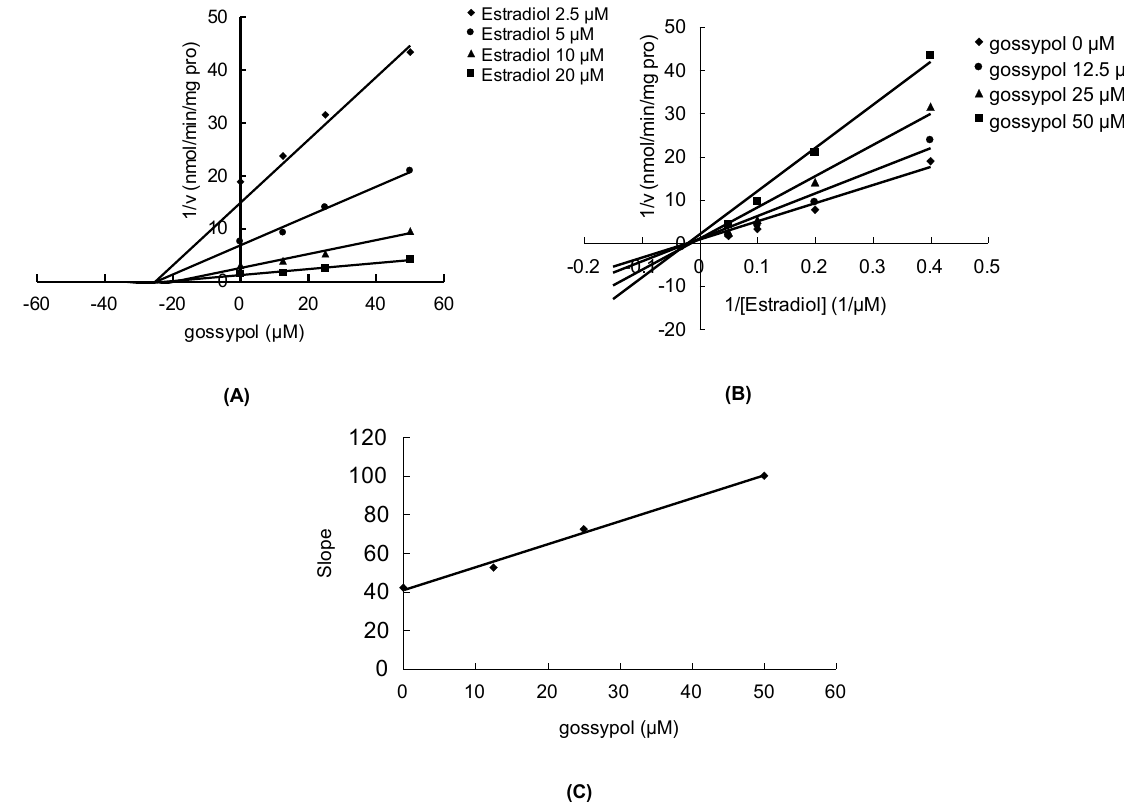
Figure 2. The inhibition of gossypol towards UGT-mediated estradiol glucuronidation. ( A ) Dixon plot of the inhibitory effect of gossypol on UGT-mediated estradiol glucuronidation; ( B ) Lineweaver-Burk plot of the inhibitory effect of gossypol on UGT-mediated estradiol glucuronidation; ( C ) Second plot of slopes from Lineweaver-Burk plot vs . gossypol concentrations. All the experiments were carried out in duplicate.